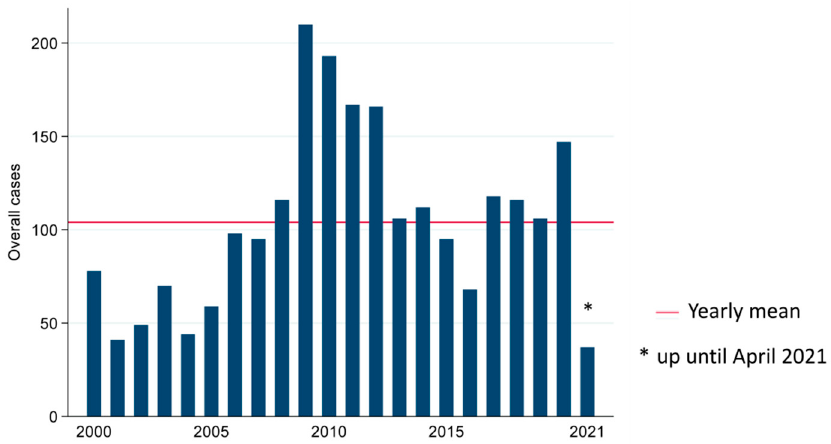
Figure 1. Annual frequency of cases submitted to the AVC ADSBL (2000–2021) for bacterial culture and isolation.